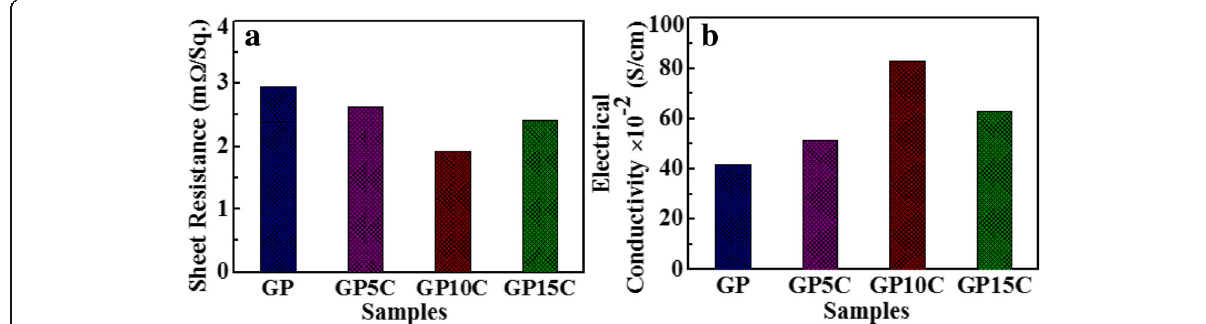
Fig. 5 a Ohmic resistances of rGO and rGO/MWCNT papers with 5, 10, and 15 wt.% MWCNT content, and b the electrical conductivities of the